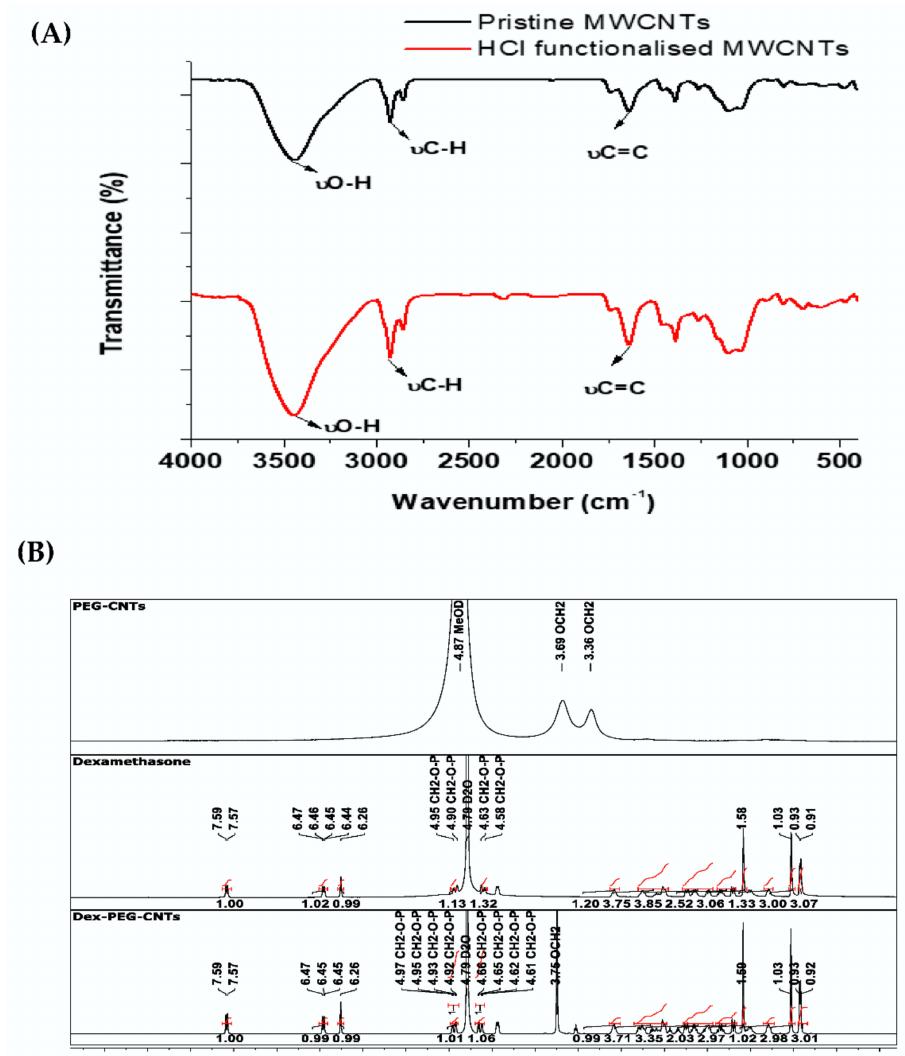
Figure 6. Molecular spectral properties of pristine and functionalized MWCNTs. FTIR spectra of pristine (red spectrum) and HCl functionalised (black spectrum) MWCNTs ( A ); 1 H-NMR spectra of PEG-CNTs, Dexamethasone, and Dex-PEG-CNTs ( B